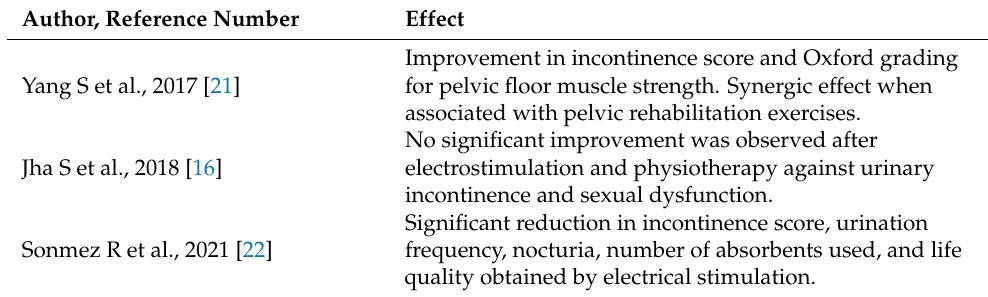
Table 4. Therapeutic effects of electrical stimulation associated or not with pelvic and perineal